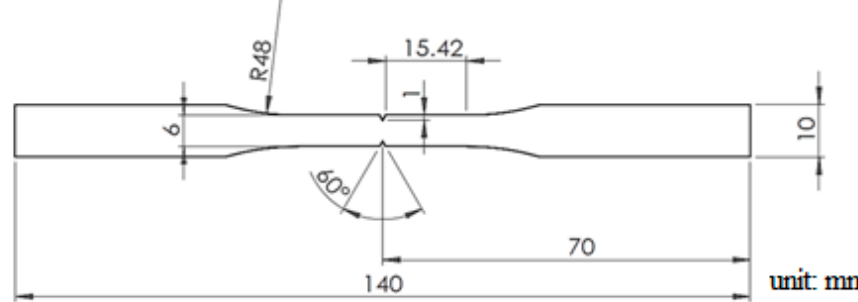
Figure 4. The notched tensile test specimen.